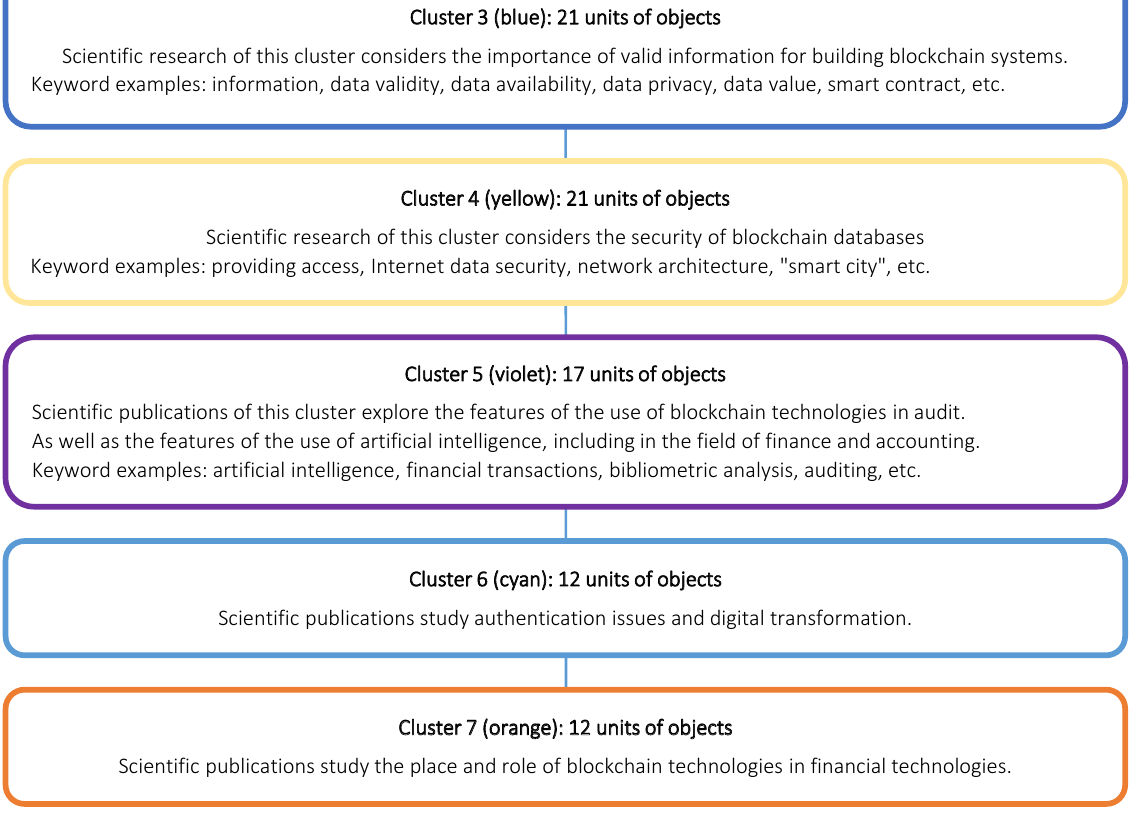
Figure 3. Characterization of bibliographic clusters based on the analysis of “keyword matches” using